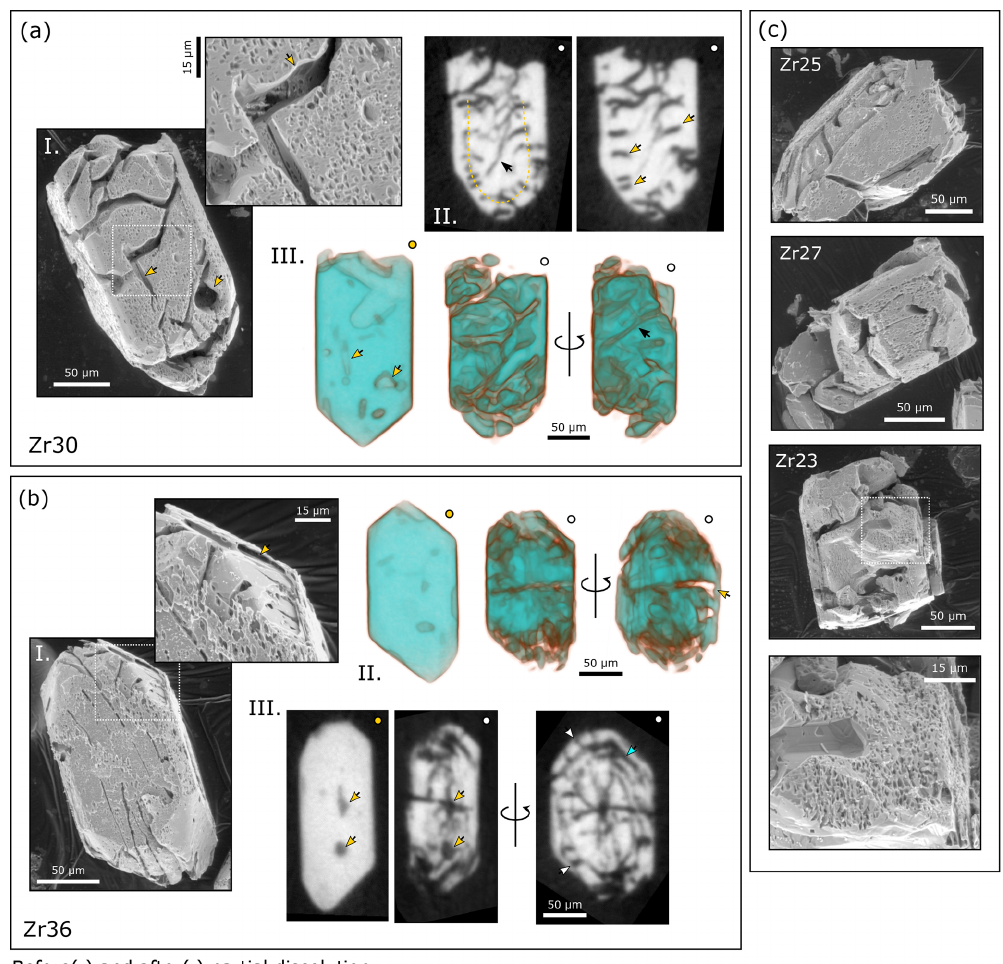
Figure 13. SE and µCT images of SAM-47 grains pre- and post-chemical abrasion at 210 ◦ C for 4h. (a) Subpanel (I) shows SE images of Zr30, showing wide fractures, the removal of mineral inclusions (yellow arrows), and a moderately etched surface. (II) 2D µCT image slices highlighting dumbbell-like features (yellow arrows) interpreted to cross-cut what could be a concentric zone (yellow dashed line). The black arrow exhibits how fractures radiate from the dumbbell features. (III) Semi-transparent 3D rendering of µCT data. Yellow arrows correlate with those in (I). The black arrow highlights how the fractures observed on the surface propagate through the crystal interior. (b) Subpanel (I) shows SE images of Zr36, showing fractures, diamond-shaped etch pits, and the targeted removal of an interior zone (yellow arrow). (II) Semi-transparent 3D rendering of µCT data. The yellow arrow highlights the grain’s shell-like appearance because of significant dissolution in the grain’s interior. (III) 2D µCT image slices showing the removal of mineral inclusions (yellow arrows), oscillatory zones (teal arrow), and dumbbell-like fractures that appear to cross-cut compositional zones (white arrows). (c) SE images of dog-chewed zircon residues Zr25, Zr27, and